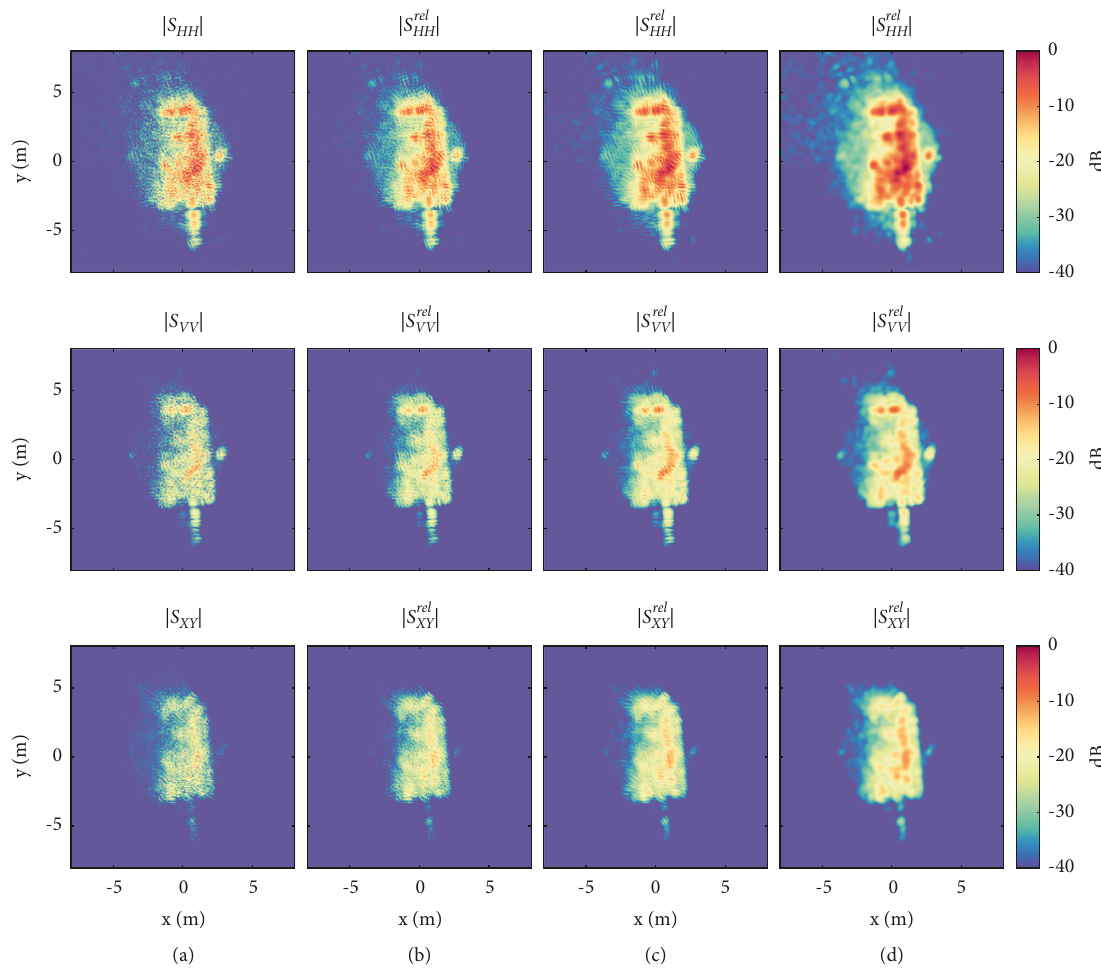
Figure 11: Scattering matrix elements for four different processing cases of extent (case 1). Subaperture-based imaging with a subaperture number of (b) 3 (case 2), (c) 7 (case 3), and (d) 21 (case